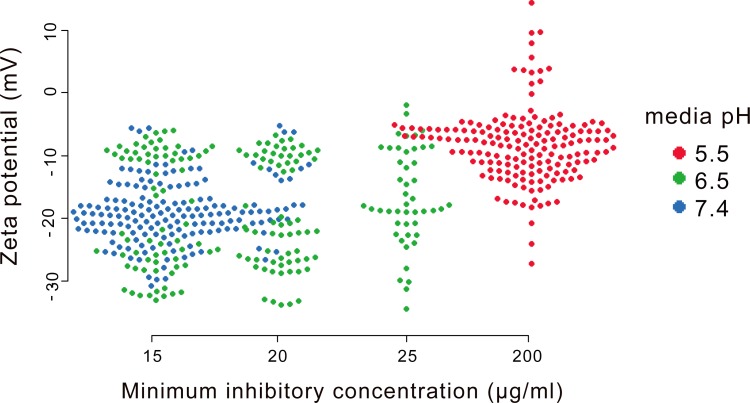
Relationship between pH, bacterial zeta potential, and minimum inhibitory concentration of PE31.Data reflect multiple replicate zeta-potential measurements and MIC measurements across ten clinical blood isolates of methicillin-resistant S. aureus.